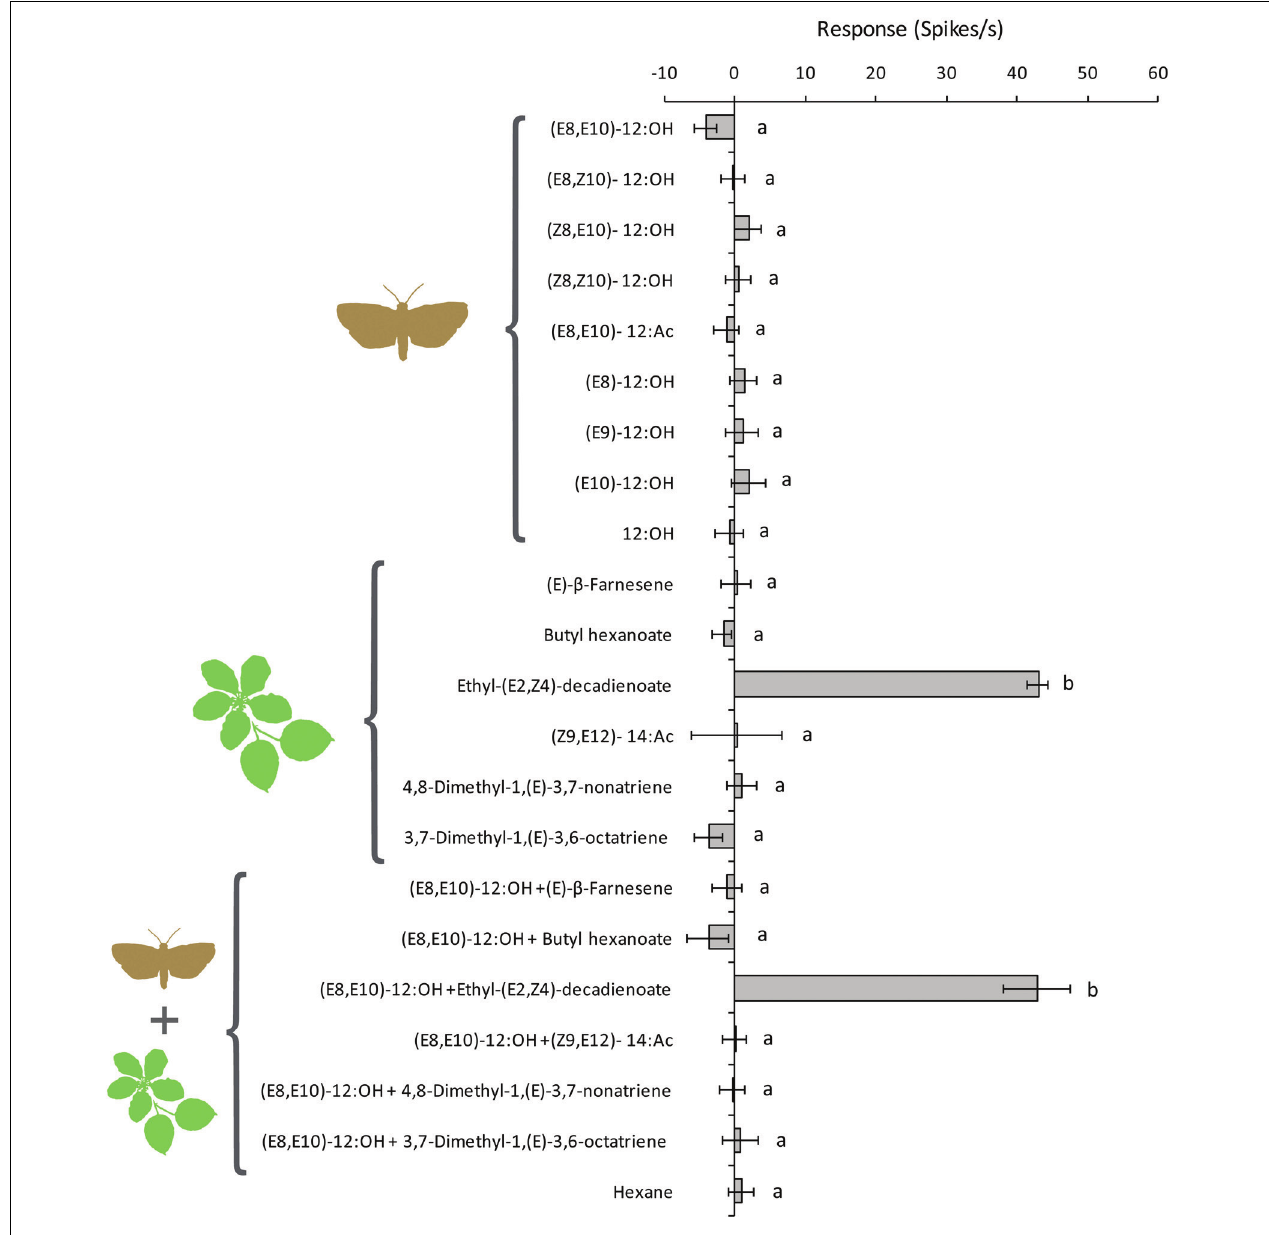
FIGURE 3 | Response (in Hz) of D. melanogaster T1 OSNs expressing CpomOR3 to stimulation with known C. pomonella pheromone components, plant-related synergists, and combinations of the main